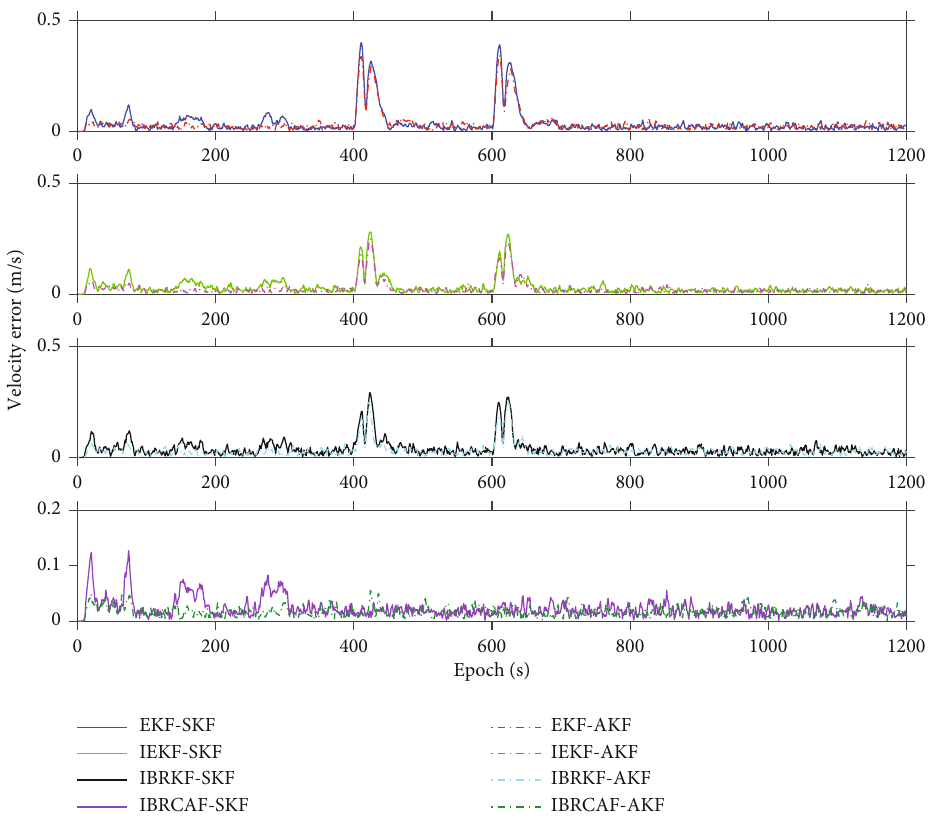
Figure 20: The velocity errors of various algorithms (Data